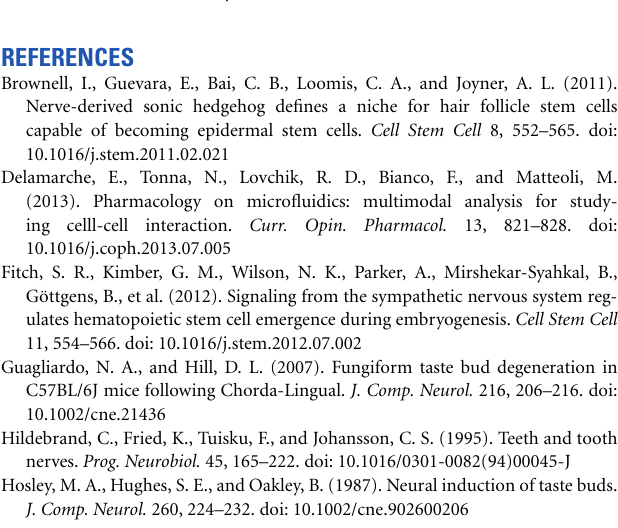
Supplementary Figure 1 | Comparison of E15.5 incisor cultured in optimal conditions and in conditions optimized for trigeminal ganglia cultures. (A) E15.5 incisor cultured in tooth culture medium (see Materials and Methods) for 10 days. The tooth shape is elongated, and the limits of the tooth are clearly visible and defined. (B) E15.5 incisor co-cultured with a trigeminal ganglion in trigeminal ganglion medium (see Materials and Methods, magnification of Figure 2C ). The incisor is smaller, and cells migrate massively from the tooth, particularly on the lingual (upper, red arrow) side. Scale bar: 500 μ